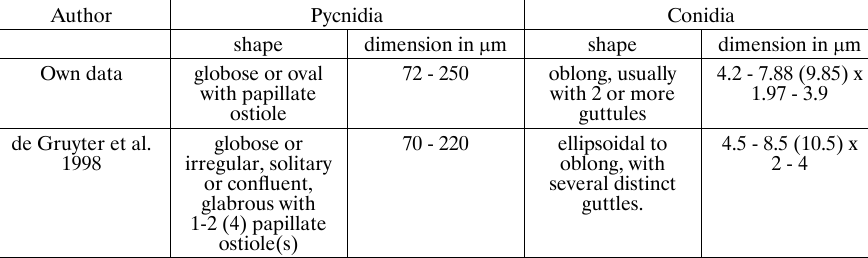
Characterization of pycnidia and conidia of Phoma negriana (mean for 4